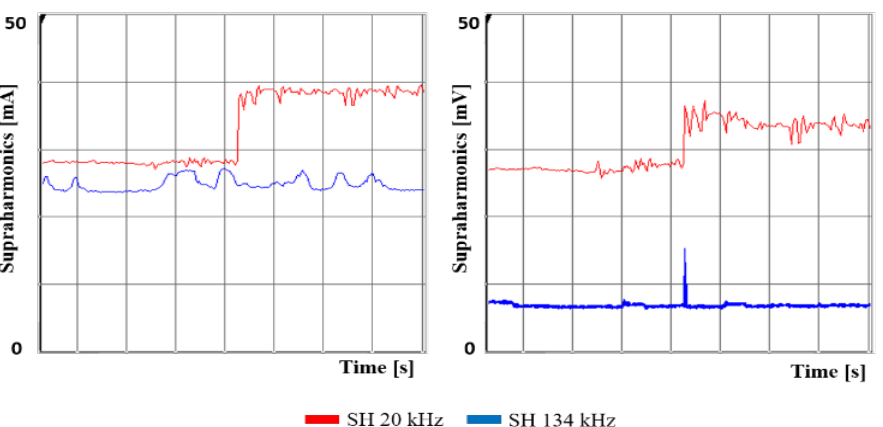
Figure 14. Supraharmonic emissions at 20 kHz and 134 kHz when switching from star to radial topology [14].